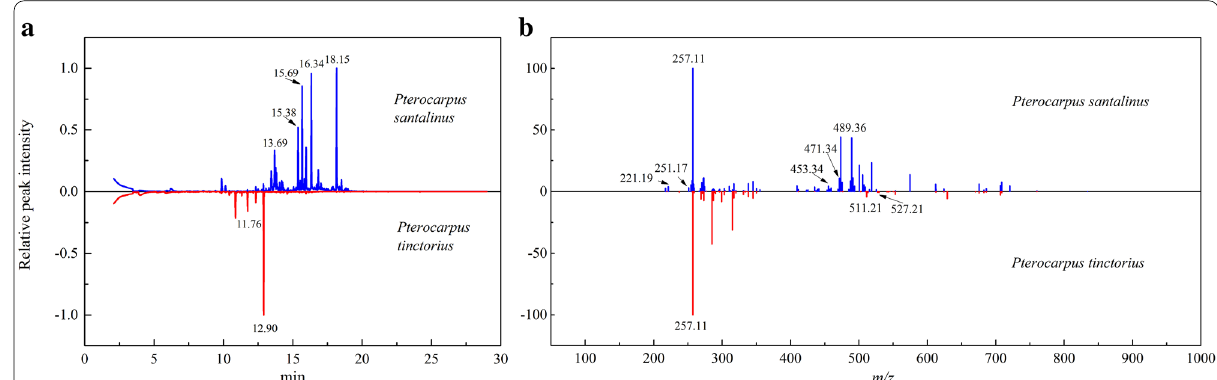
Fig. 2 Total ion current diagram of HS–GC–MS ( a ) and the representative DART–MS spectra ( b ) for Pterocarpus santalinus and Pterocarpus tinctorius